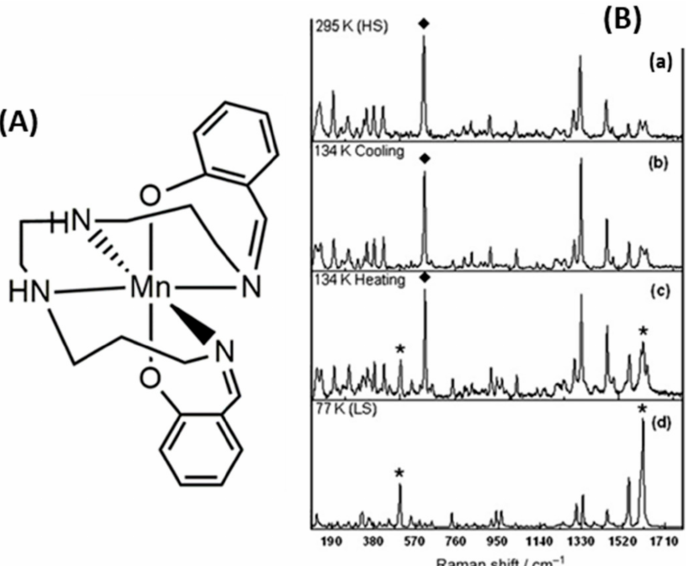
Figure 7. ( A ) Structural drawing of the [MnL 1 ]PF 6 (complex 9 ); the PF 6 counter lattice ions are not presented. ( B ) Raman spectra in (a) fully HS (295 K) and (d) fully LS (77 K) states and at T = 134 K for the cooling (b) and heating (c) mode. HS-associated modes are indicated by (cid:7) and LS by *. ( B ) is reprinted with permission from ref. [88], copyright 2012,